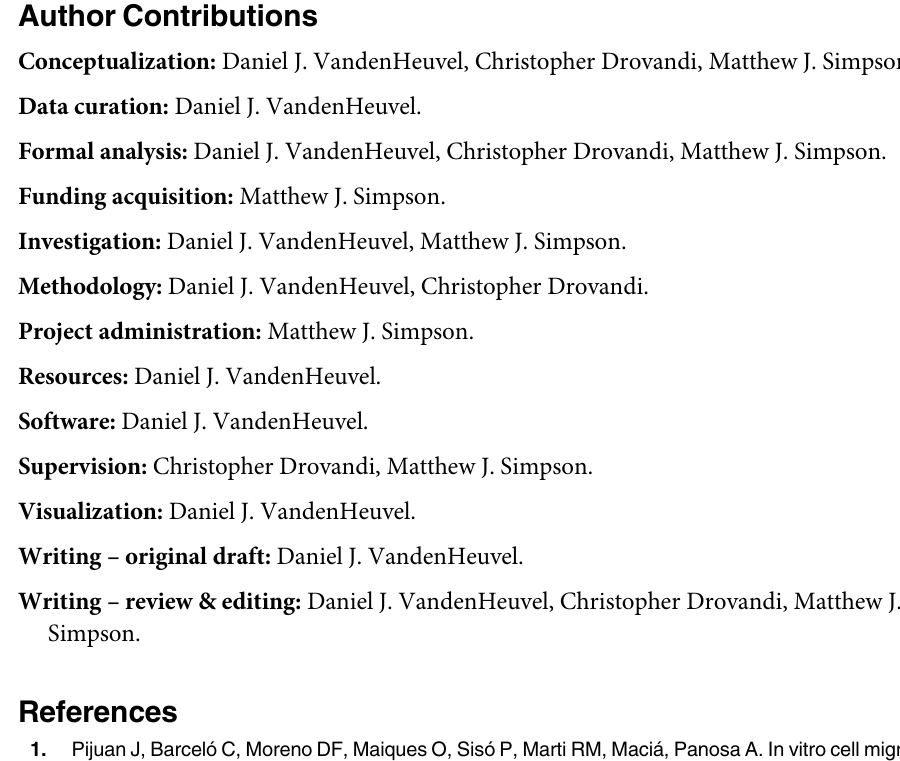
S5 Table H. Model selection results for the five models considered with N = 50. Interval esti- p mates, PDE errors, and model selection results for the models in Eq 2–6 when applied to each data set from Jin et al. [13]. The time taken to produce these results is 56 minutes and 7 seconds. S5 Fig V. Coefficient comparisons for different grid sizes . Comparing coefficients from model 2 for each data set, using different values for N . The lines shown are the 95% confidence p intervals for the corresponding coefficient. The coefficients are all scaled by a value ^ y , e.g. α is 1 scaled by ^ a , where ^ y is the mean value of the coefficient from the results using N = 500 for that p 1 data set, and similarly for the PDE errors. S6 Table I. Grid and density notation . Notation used for several grids and for labelling the den- sity values. S6 Table J. Gaussian process notation . Notation used for the Gaussian processes. S6 Table K. Equation learning, bootstrapping, and model selection notation . Notation used for equation learning, bootstrapping, and model